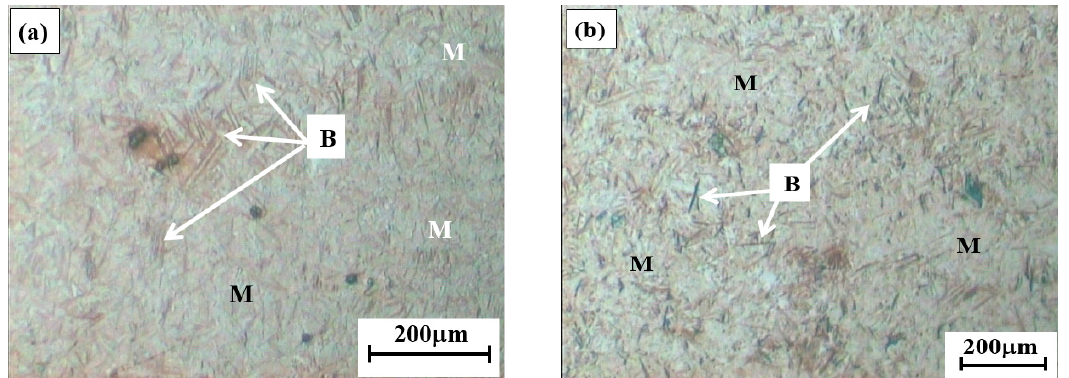
Figure 2. Optical micrographs of Q&B samples isothermally treated at 350 °C for 5s after etching in: ( a ) 2% nital; and ( b ) 5% picral reagents. In these micrographs bainite plates (B) superimposed in the martensitic matrix (M) are observed by black or light black and light brown contrasting areas, respectively.